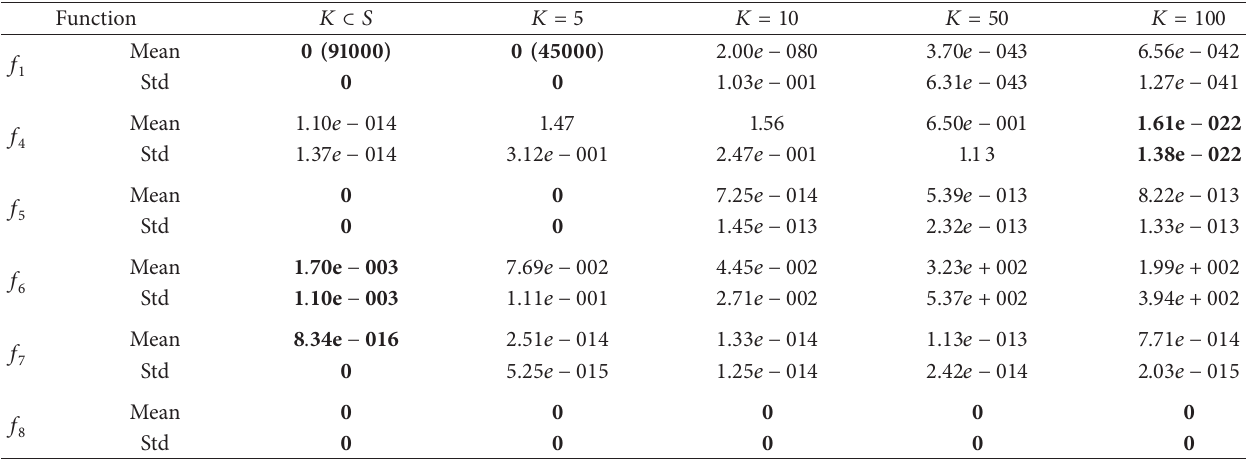
Table 6: Performance of HABC AW on 100D 𝑓 1 and 𝑓 4 – 𝑓 8 with the different grouping number 𝐾 . In bold are the best